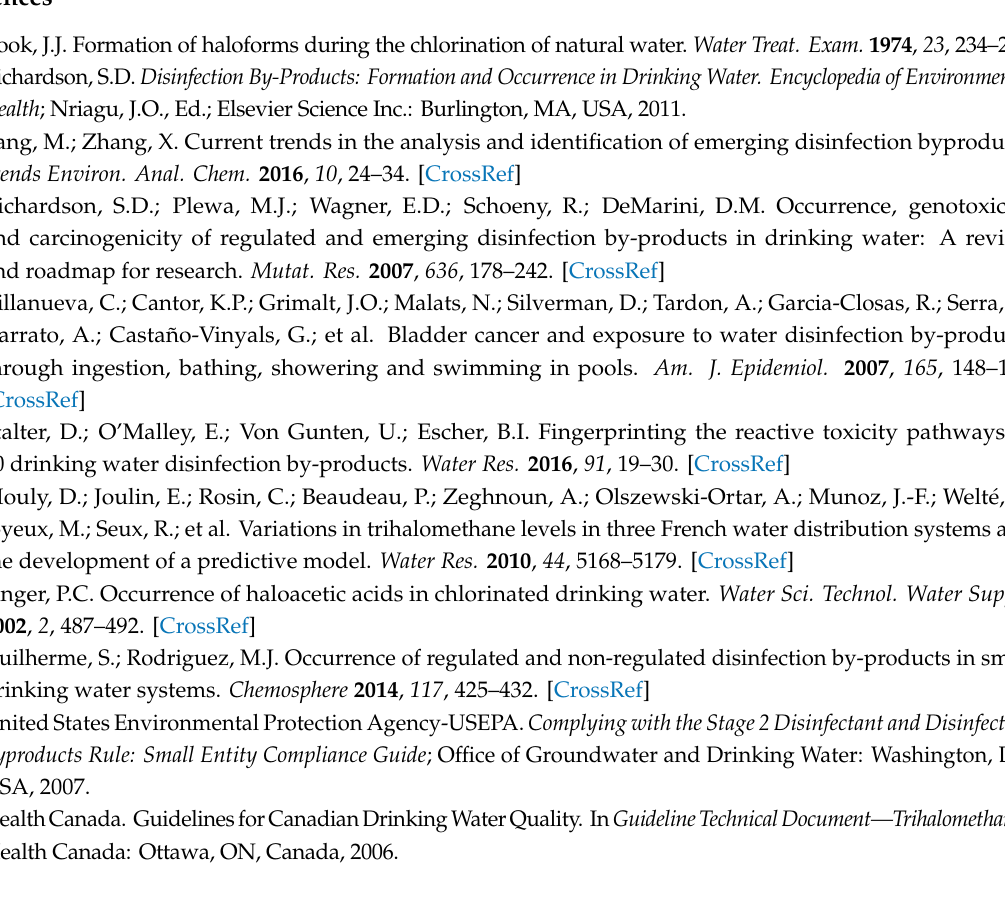
Supplementary Figure S1: Residual analysis of HAAs_level_1 linear regression, Supplementary Figure S2: Residual analysis of THMs_level_1 linear regression, Supplementary Figure S3: Residual analysis of HAAs_level_2 linear regression, Supplementary Figure S4: Residual analysis of THMs_level_2 linear